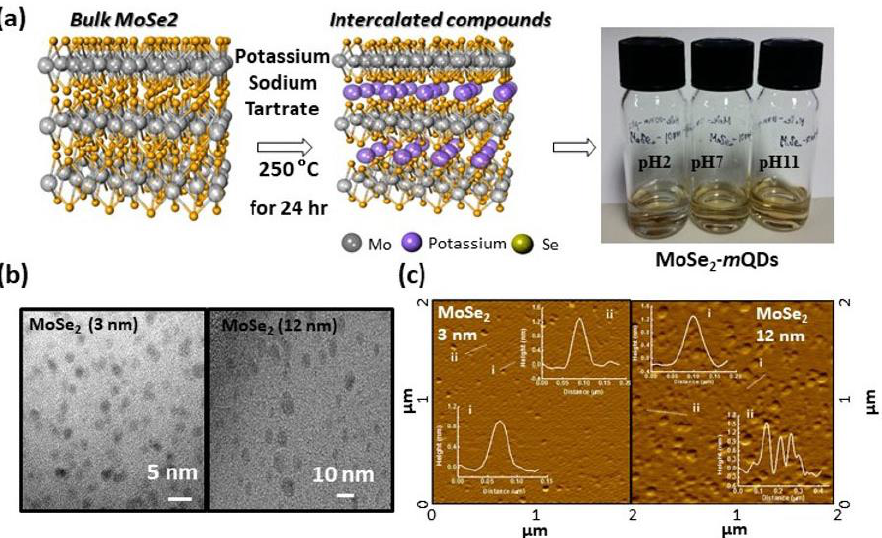
Figure 1. Synthesis and characterization of MoSe 2 - m QD [15]. ( a ). Schematic illustration of synthetic process of MoSe 2 - m QD and digital images of dispersed MoSe 2 - m QD in water with ph 2, 7, and 11. ( b ). TEM images of MoSe 2 - m QD- L (right) and MoSe 2 - m QD- S (left). ( c ). AFM images of MoSe 2 - m QD- S (left) and MoSe 2 - m QD- L (right) with height profiles.